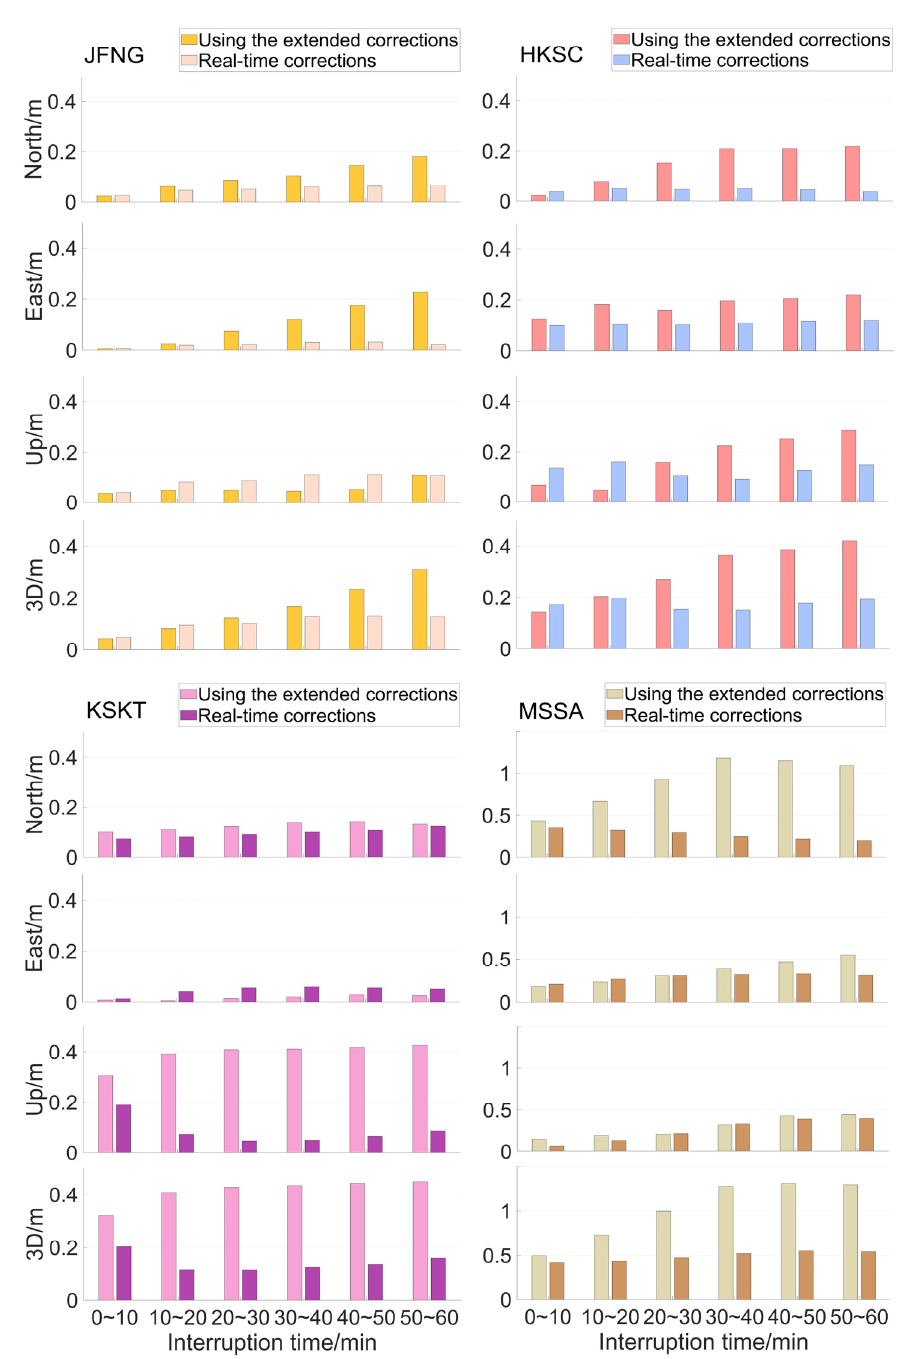
Figure 14. Accuracy of the remaining four stations in the north, east, and up directions, and 3D coordinates after the interruption at 16:30:00 and without the interruption.